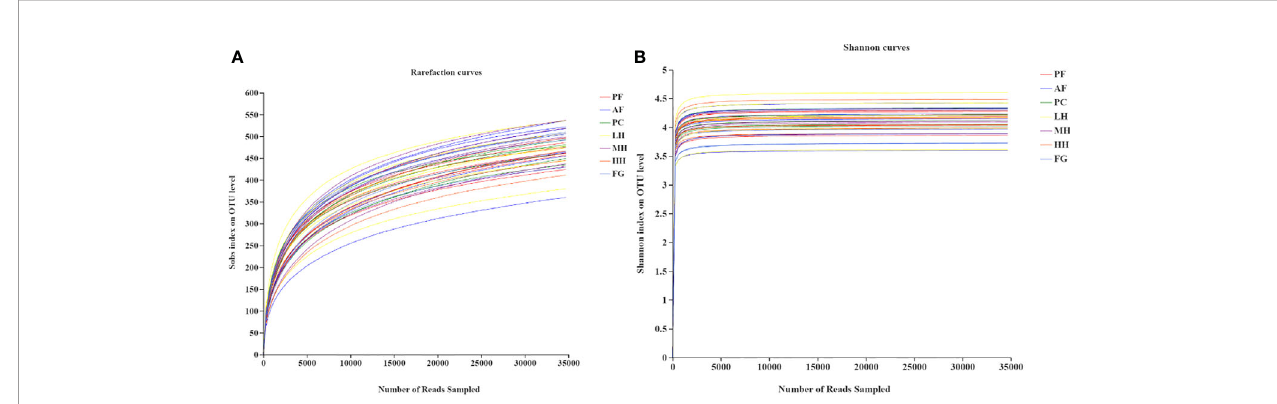
FIGURE 3 | Rarefaction analysis (A) and Shannon index (B) of gut microbiota from seven groups of